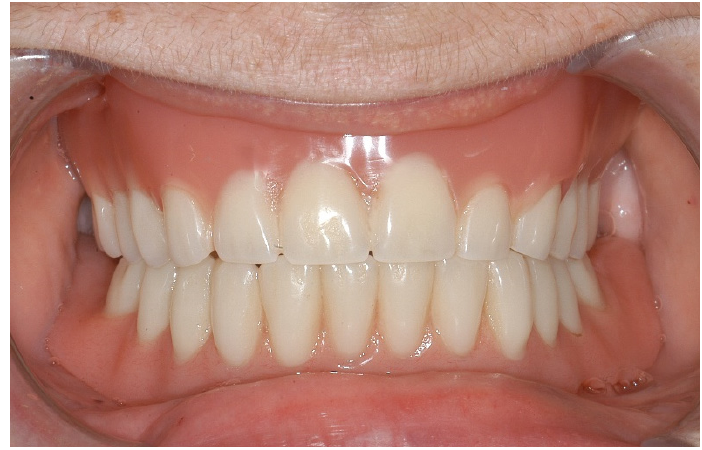
Figure 7. Final restauration after one year. The upper jaw was restored with a full denture.